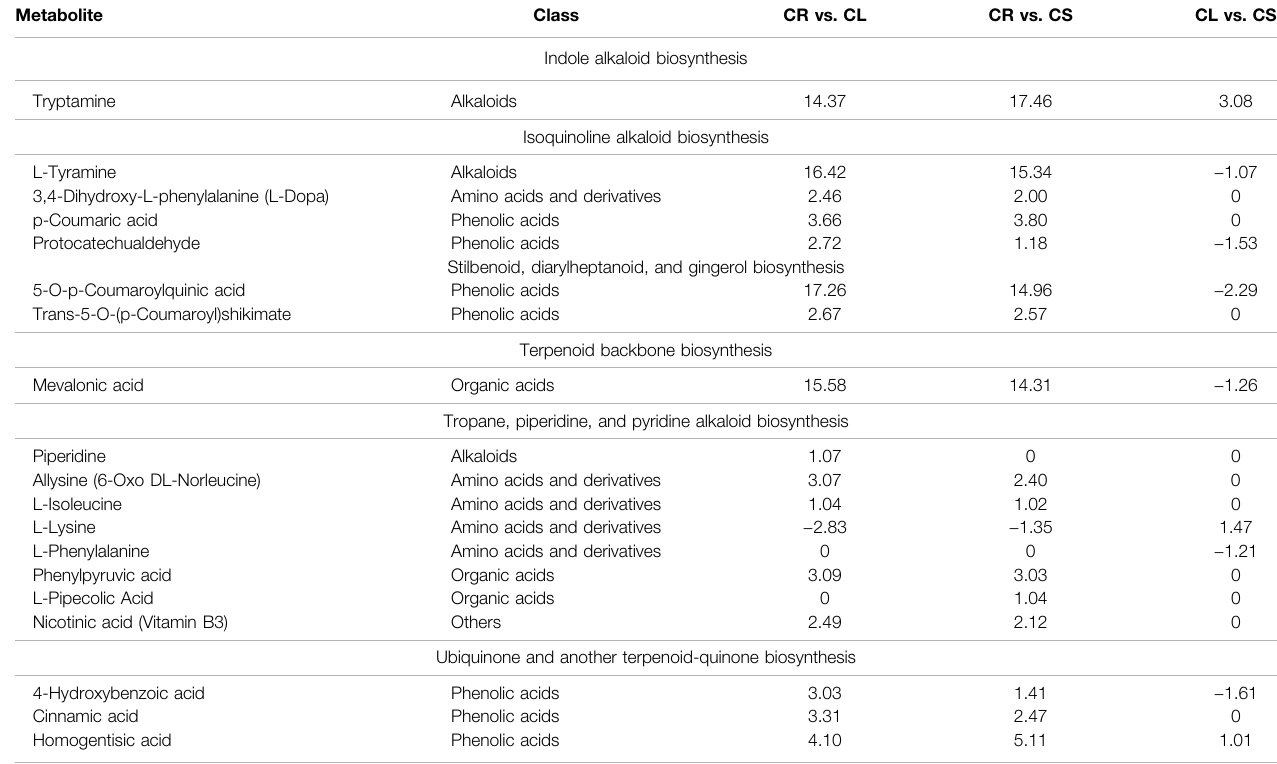
TABLE 1 | Log2 foldchange values of the differentially accumulated metabolites in C. convolvulacea leaf (CL), stem (CS), and tuber (CR) enriched in important KEGG pathways.